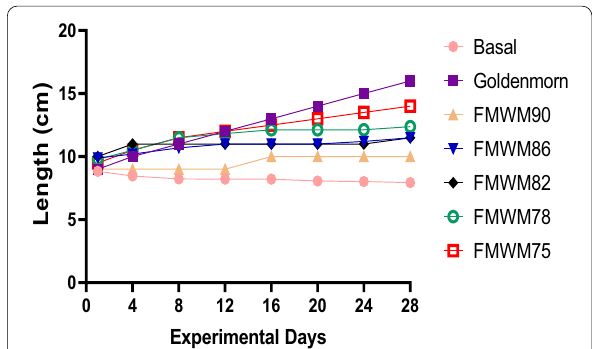
Fig. 2 Length-for-days of the experimental animal. Key: Basal (animal chow); Goldenmorn (commercial control breakfast meal); MFMWM90: Malted finger millet:Watermelon seeds (90.00:10.00%); MFMWM86: Malted finger millet:Watermelon seeds (86.25:13.75%); MFMWM82: